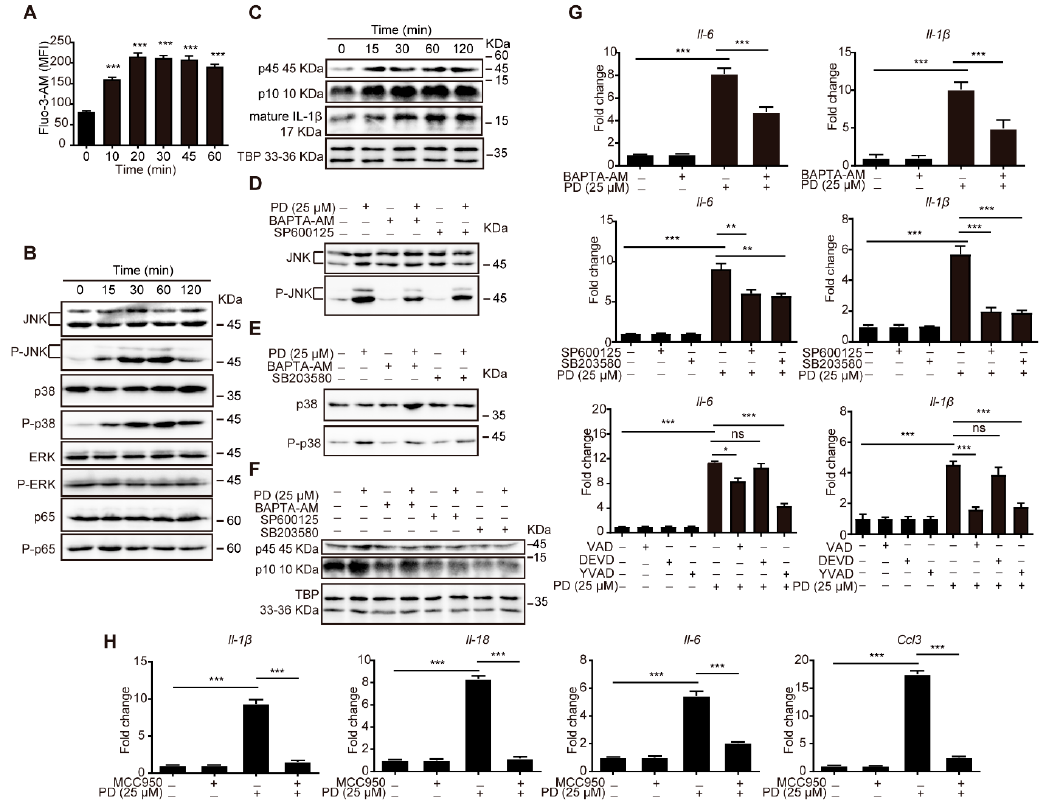
Figure 6. Ca 2+ − JNK/p38 MAPK − NLRP3 inflammasome–caspase-1 pathway was essential for the inflammatory response in C2C12 cells by PD. ( A ) The levels of intracellular free calcium in C2C12 cells treated with PD (25 µ M) for 0–60 min by flow cytometry. ( B ) C2C12 cells were treated with PD (25 µ M) for 0, 15, 30, 60, and 120 min, and the protein levels were detected by Western blotting. The figure shown was representative of three independent experiments. ( C ) C2C12 cells were stimulated with PD (25 μ M) at the indicated time, and the activated caspase-1 and mature IL-1 β protein levels were analyzed by immunoblotting. p45, pro-caspase-1; p10, activated caspase-1. The figures shown were representative of three independent experiments. ( D − F ) After pre-incubation with or without BAPTA-AM (10 µ M, 30 min), SP600125 (10 µ M, 1h), or SB203580 (20 µ M, 1 h), C2C12 cells were treated with medium or